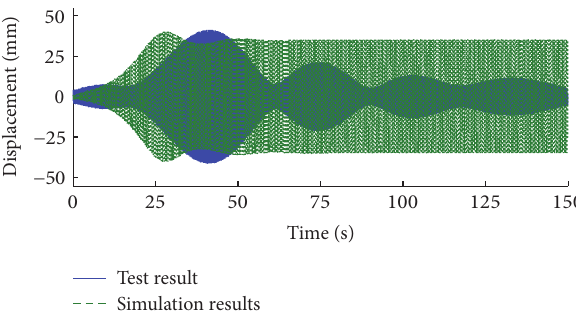
Figure 16: Contrast of the experiment and numerical stimulation of cable displacement while 𝑊 𝐵 equals 3 mm.